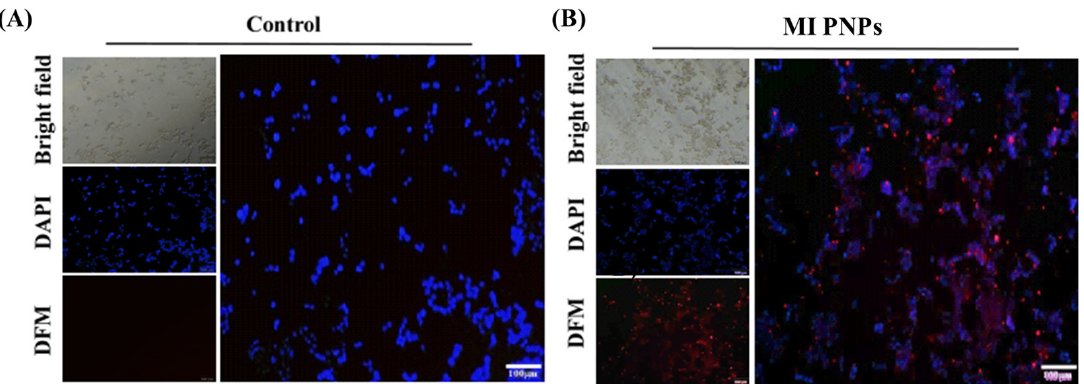
Figure 4. Fluorescent microscopy images of ( A ) untreated cells and ( B ) cells treated with MI PNPS indicating the cellular internalization efficacy of the MI PNPs.